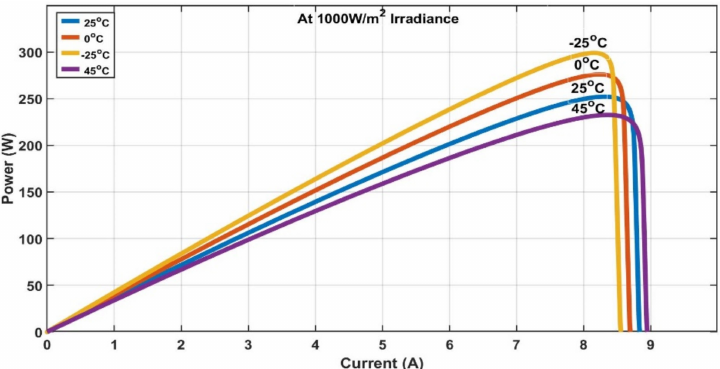
Figure 13. P-I curves with different temperatures at 1000 W/m 2